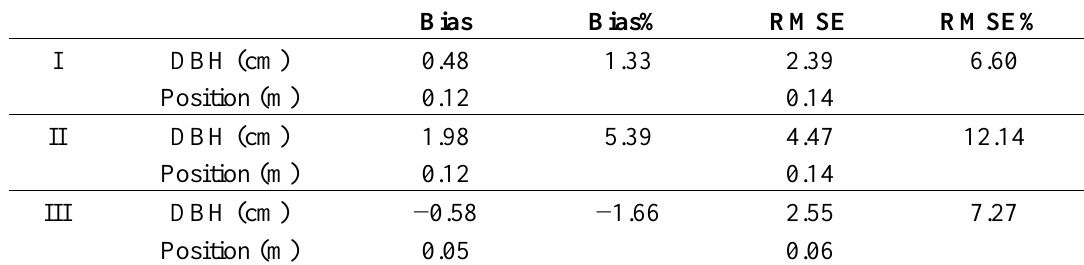
Table 2. The accuracy of the DBH and position estimates utilizing image-based and TLS point clouds. Bias Bias%